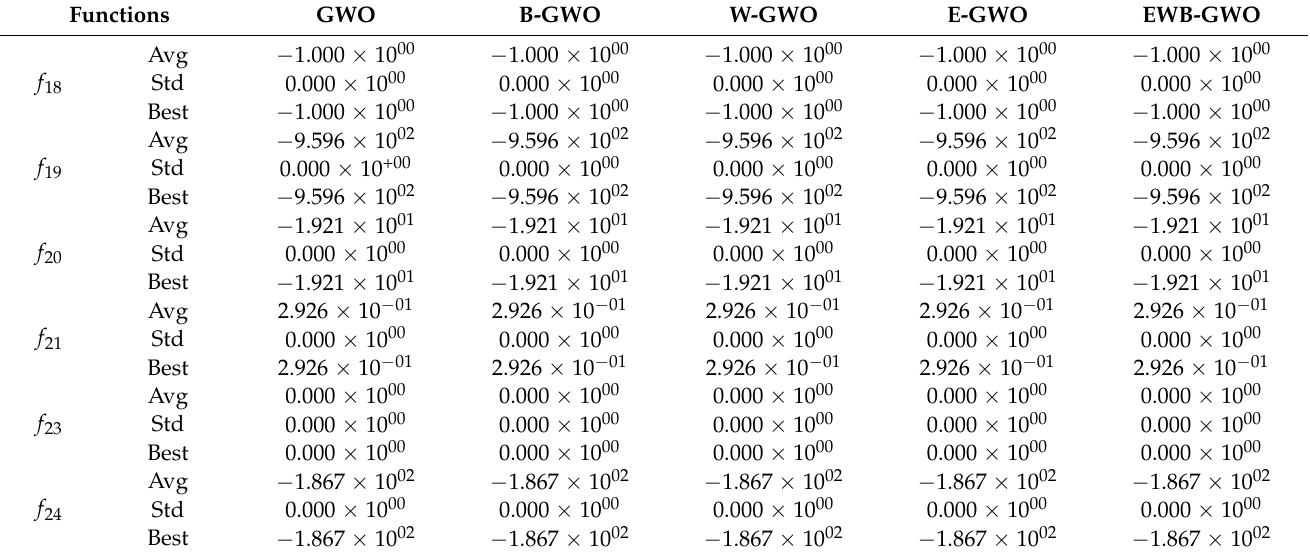
Table 4. Test results of the algorithm in fixed-dimensional multimodal function